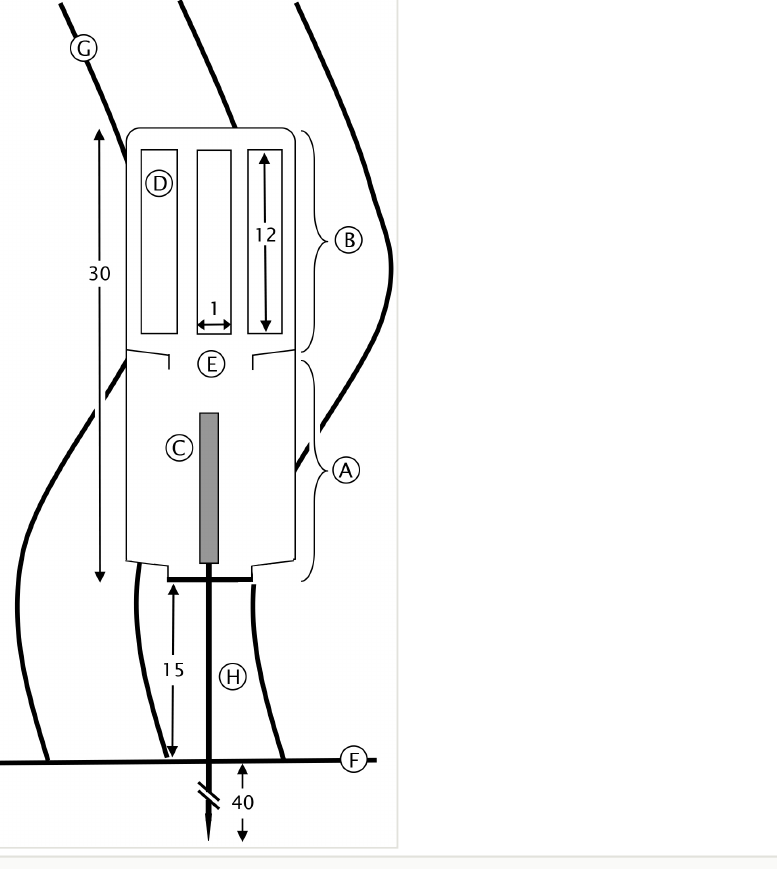
Figure 1. Schematic representation of the second type of light traps used in this study. All measurements are expressed in centimetres. A: bottom container, B: top container, C: diving emergency light stick, D: vertical slits, E: bottleneck, F: bottom, G: Posidonia oceanica leaves, H: metal Step description: After collection, all samples were sieved on 400 µm nylon mesh to eliminate sediment and fi ne particulate organic matter. They were subsequently fi xed for >24 hours in a formaldehyde solution (4% in 0.22 µm- fi ltered seawater). Samples were then sorted to isolate amphipods and transfer them to a preservation solution consisting of 70% ethanol in distilled water to which 1% glycerine was added to prevent evaporation. After identi fi cation, specimens were stored in this preservation solution in airtight vials.